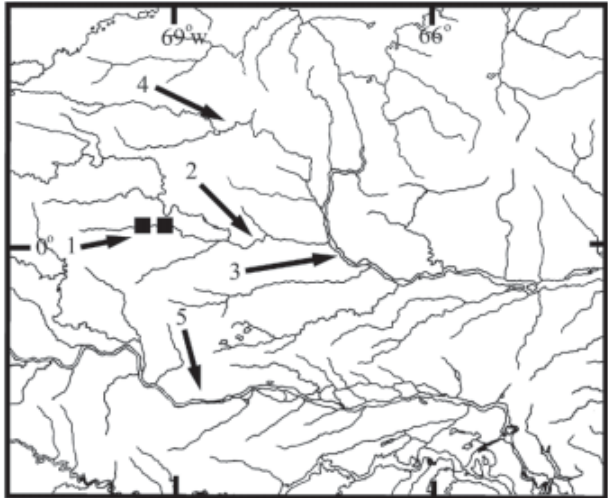
Fig. 6. Upper rio Negro basin and adjoining river basins, showing the distribution of Corydoras tukano (squares). 1- Type locality, rio Tiquié; 2- rio Uaupés; 3 – rio Negro; 4- rio Içana; and 5 – rio